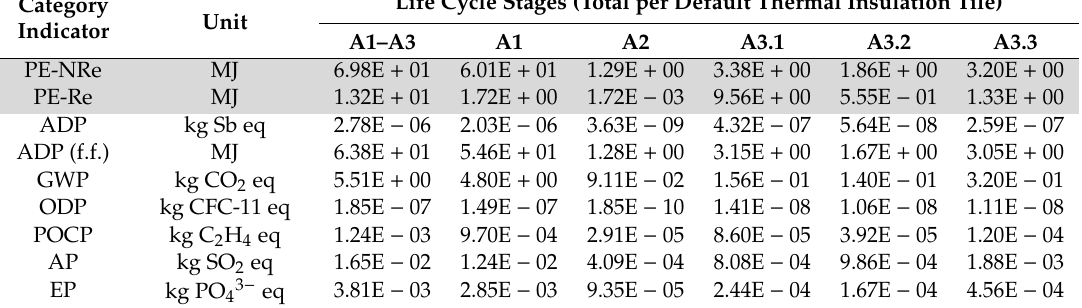
Table 5. LCA results for each sub-stage of the “product stage” (A1–A3) of one default thermal insulation tile for flat roofs.